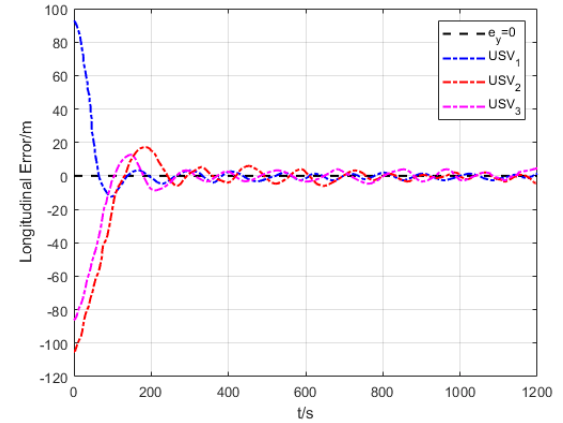
Figure 33. Variation of USV transverse error.